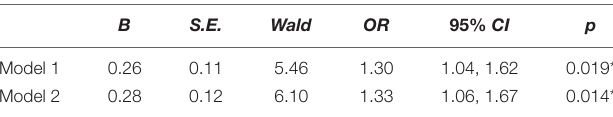
TABLE 3 | Binary logistic regression analysis for the association between total CSVD burden and MCI after propensity score